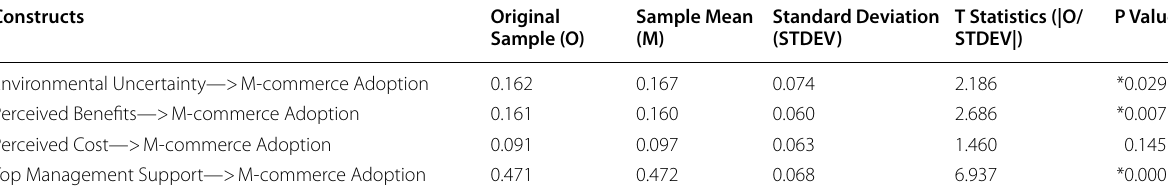
Table 7 Summary results of the hypothesis development